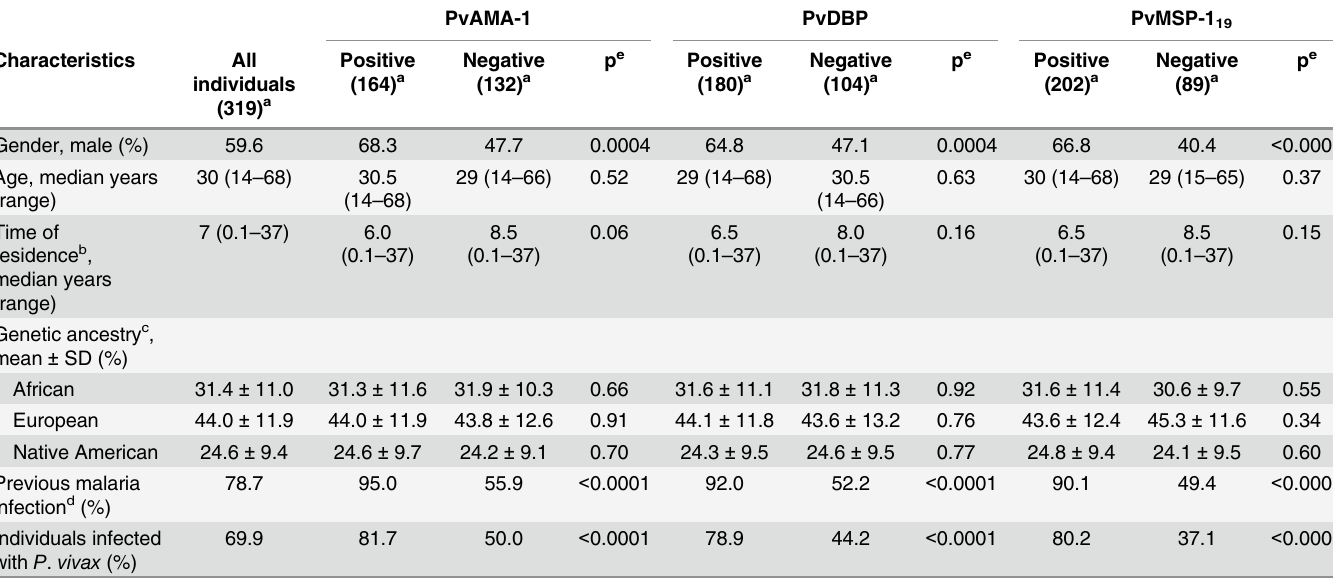
Table 1. Summary of the epidemiological data and seropositivity of the study population.